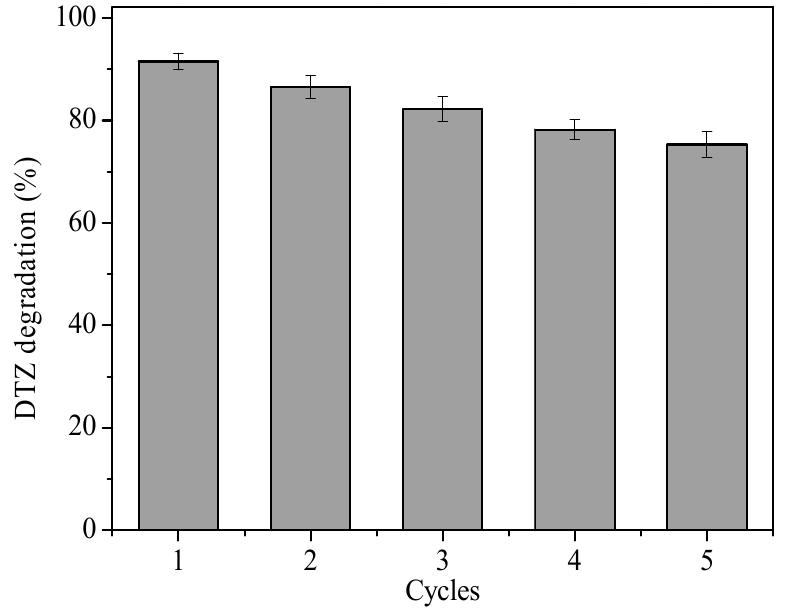
Figure 13. Reusability investigation of nZVI/2BC composite materials for DTZ degradation. [DTZ] = 20 mg L − 1 ; [PS] = 25.0 mM; [nZVI/2BC] = 0.45 g L − 1 ; Temp = 25 °C; pH = 7.0.